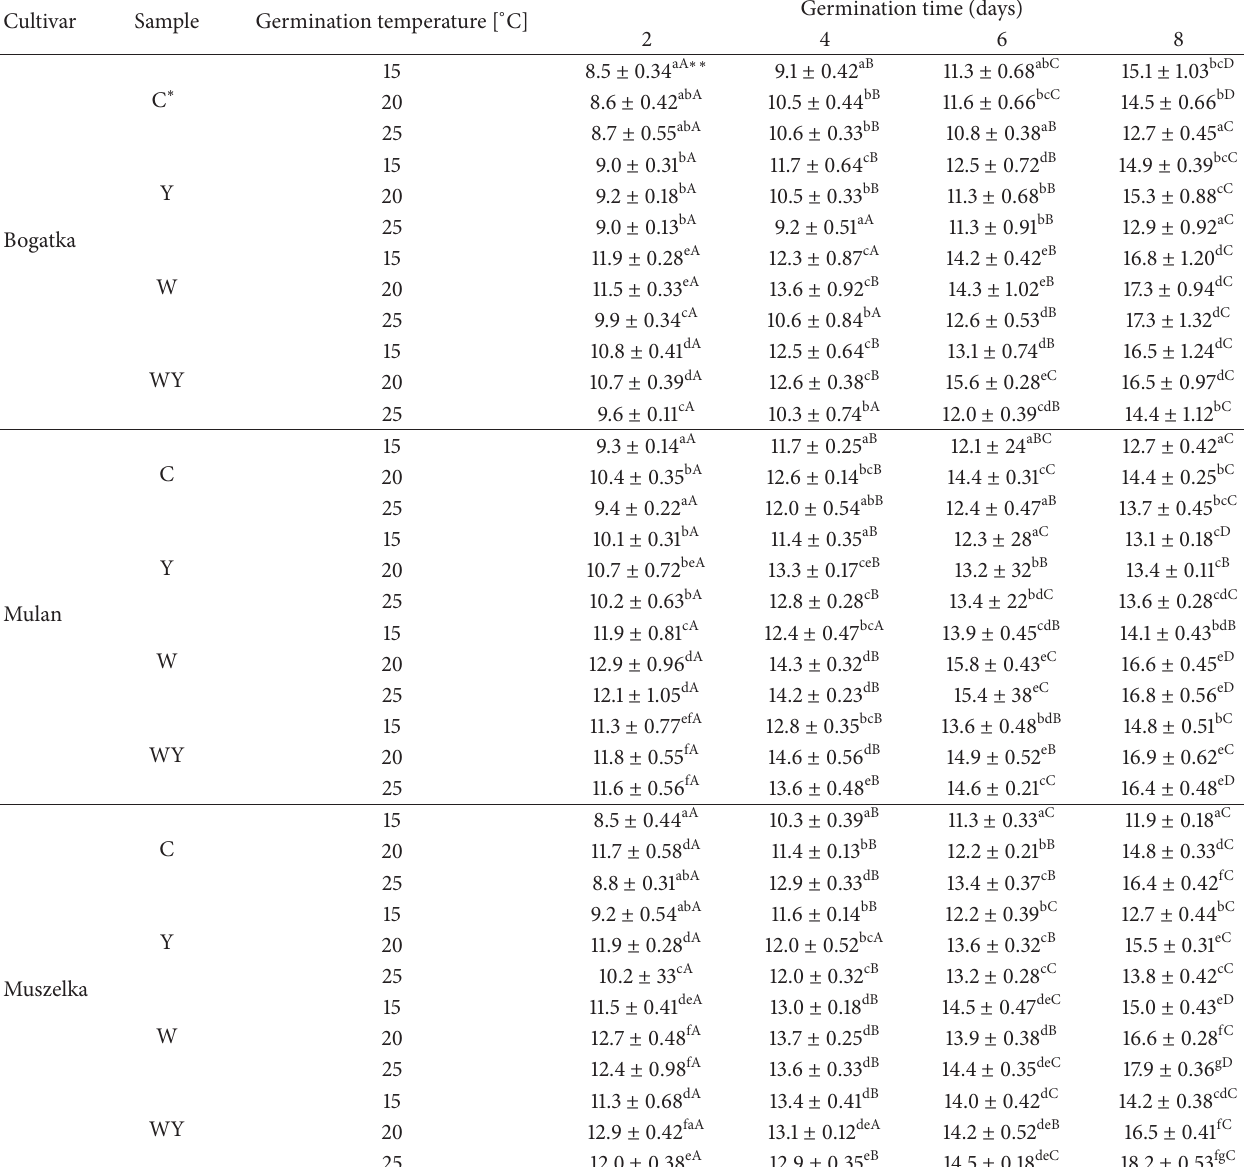
Table 1: Antioxidant activity [%] of control and elicited wheat spouts in relation to germination temperature and germination time.